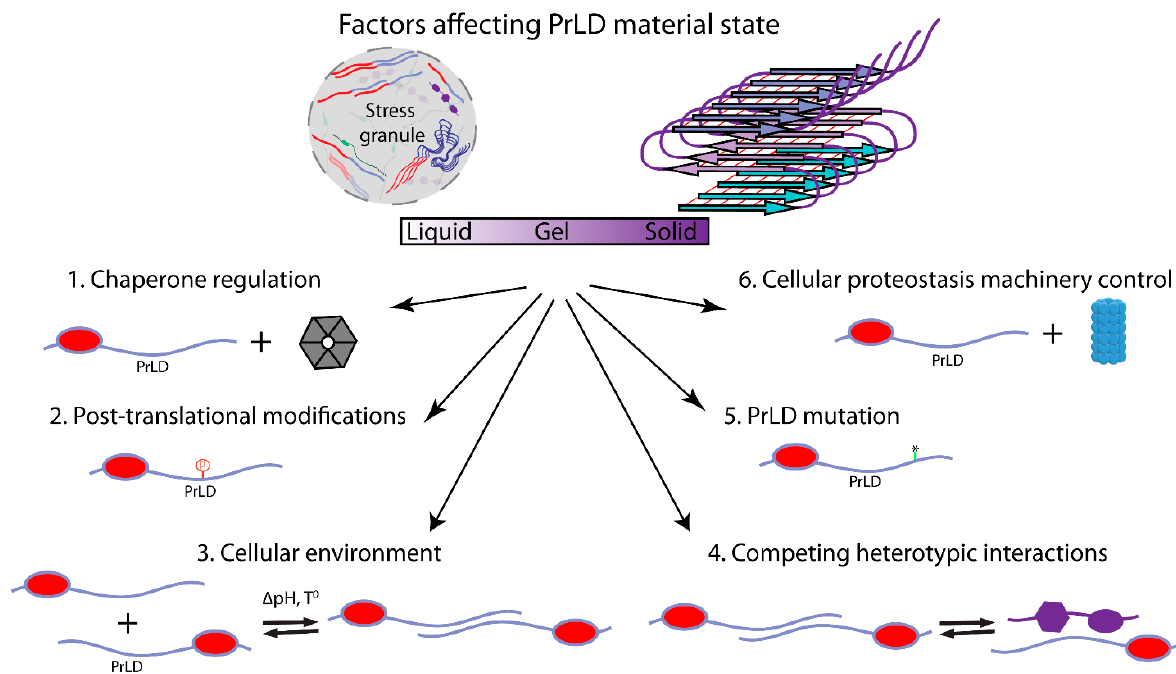
Figure 3. Some of the key factors that affect interactions and the material state of PrLDs in cells. Post-translational modifications and PrLD mutation can affect both intrinsic assembly propensity and interactions with other partners. Changes in the cellular environment can directly alter the assembly propensity of PrLDs or alter regulatory interactions. Changes in the concentration or localization of PrLDs and their binding partners can modulate their assembly propensity. Chaperones and cellular proteostasis machinery affect the concentration of proteins and modulate the dynamics of interactions.